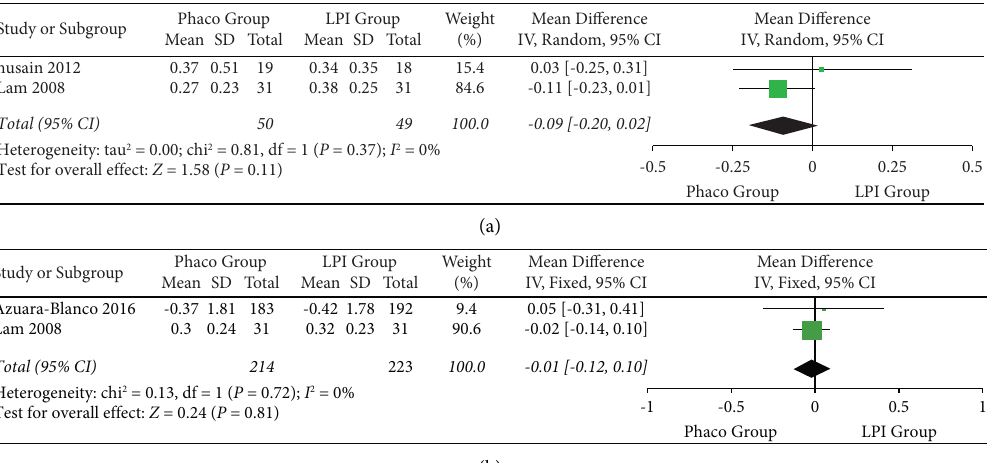
Total (95% CI) Heterogeneity: chi 2 = 0.16, df = 1 ( P = 0.69); I 2 = 0% Test for overall efect: Z = 0.87 ( P = Figure 6: Te forest plot comparing corneal endothelial cell count between the Phaco groups and LPI groups at six months after the operation.